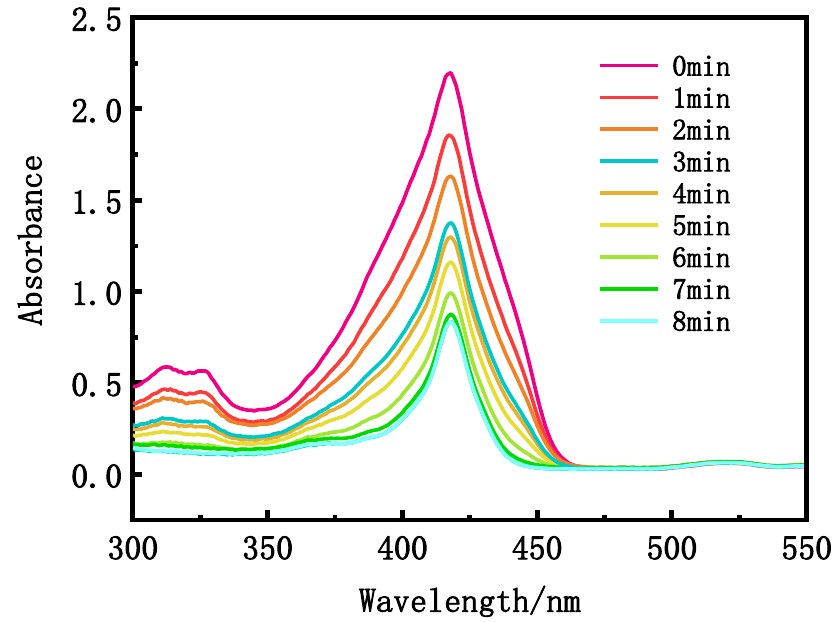
Figure 5. UV–vis spectra for the determination of singlet oxygen generation quantum yield of THPP-(PNIPAM- b -PMAGA) 4 in DMF use DPBF as quencher (λ = 410 nm).